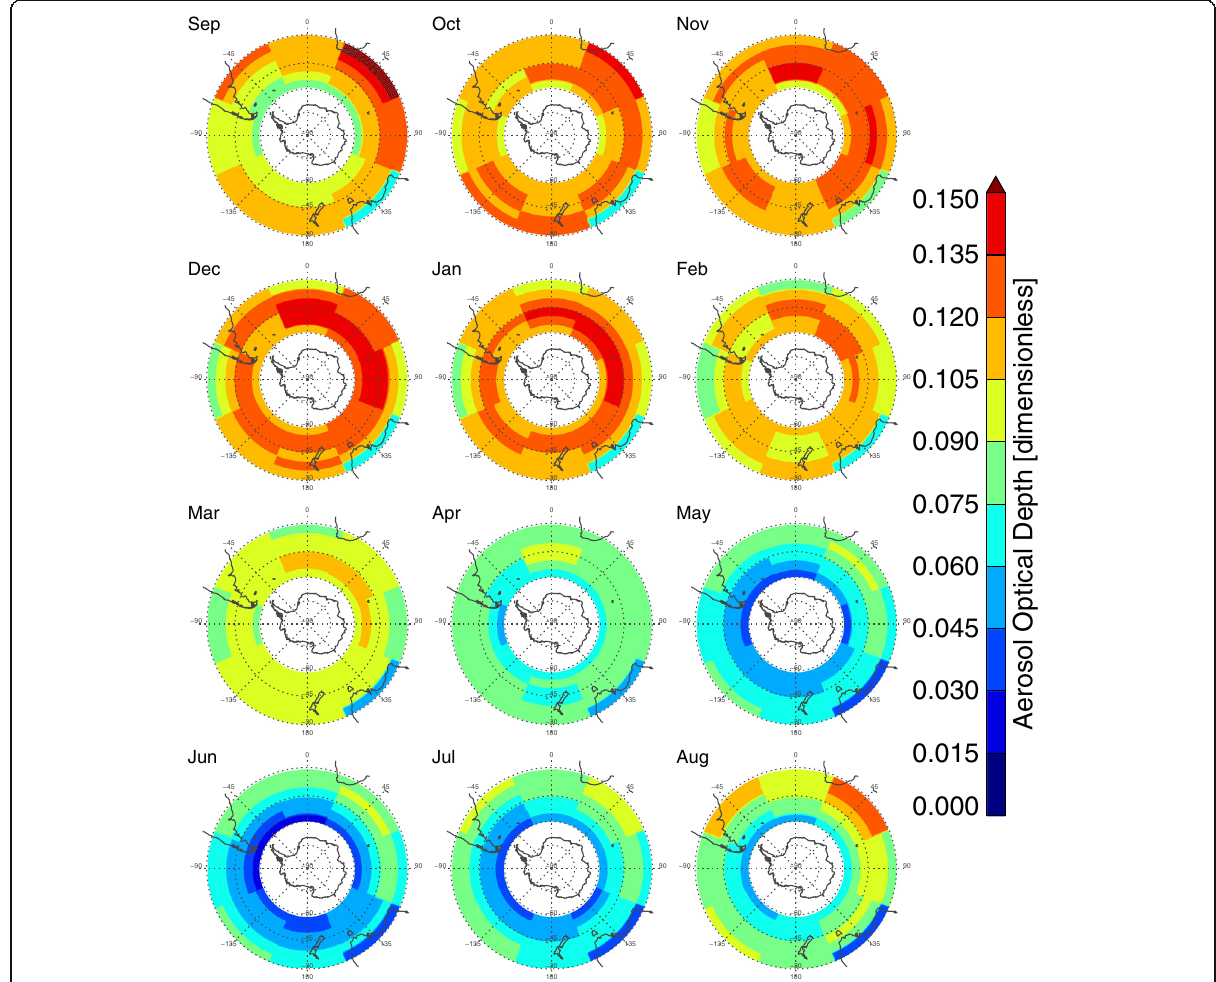
Fig. 1 Climatological monthly mean distribution of the MODIS aerosol optical depth (AOD) at 550 nm (dimensionless) at 30 – 60° S. The color in each pixel reveals the median AOD value for all available measurements from 2005 to